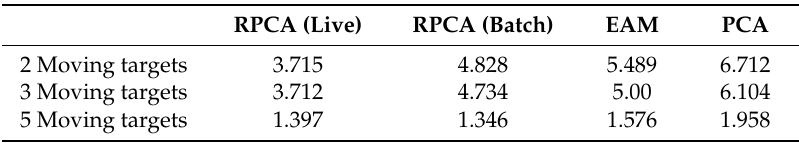
Table 2. Numeric results (RMSE) for a multiple-person scenario.